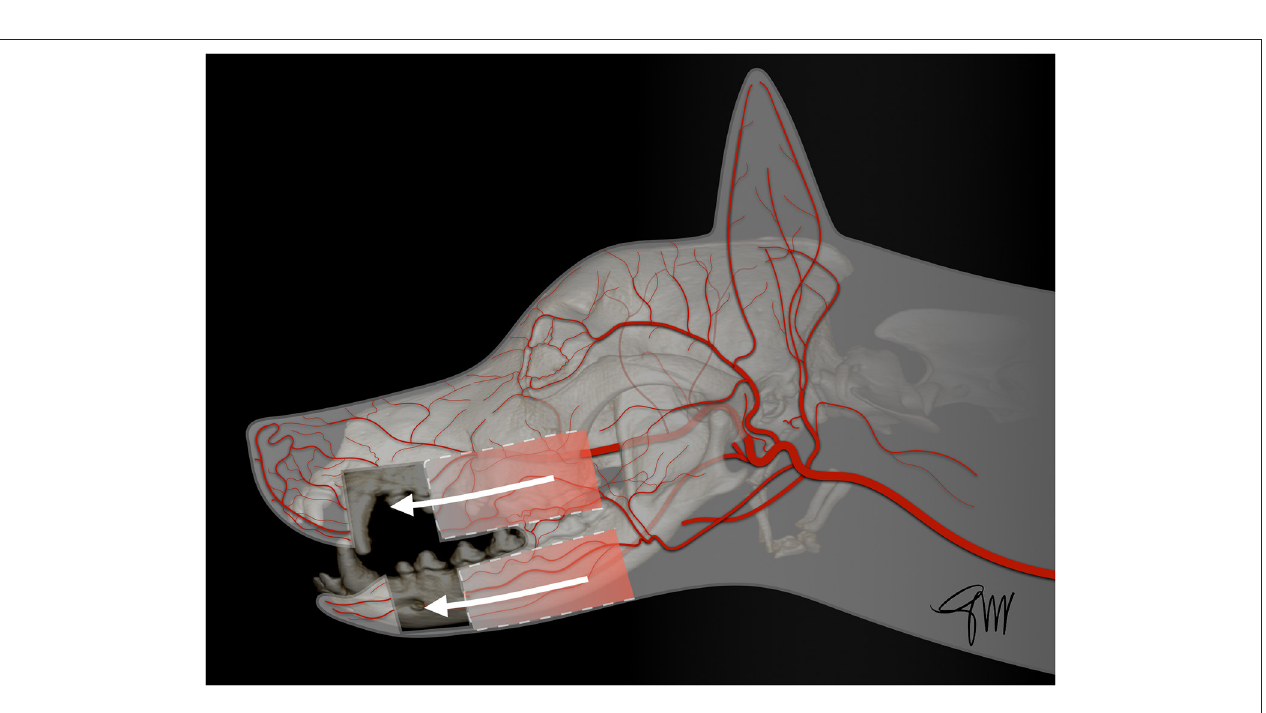
rotational in its direction, it also spans the defect by stretching the elastic tissues (76). The ideal defect for a rotation flap is triangular in shape. The flap is rotated at a maximum of 90 ◦ from the axis of the defect. The height-width ratio of the triangle ideally should be 2:1. The length of the flap should be 4 times the width of the base of the triangular defect (76).